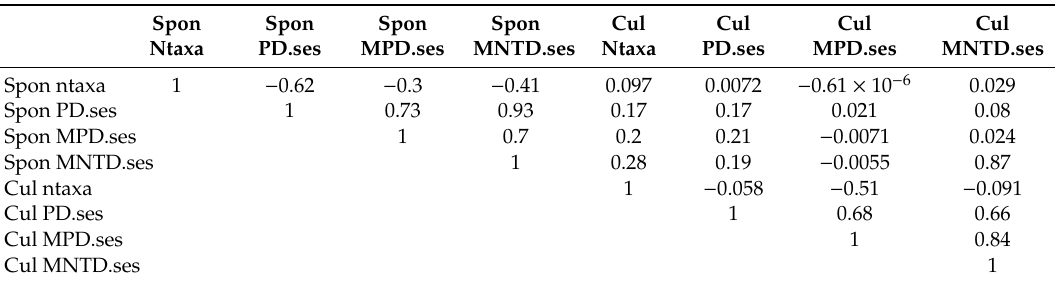
Table 1. The correlation coe ffi cients between eight pairs of biodiversity indices. The Mean Nearest Taxon Distance standardized e ff ect size (MNTD.ses) of cultivated and spontaneous plants were removed because their correlation coe ffi cients were more than | 0.7 |